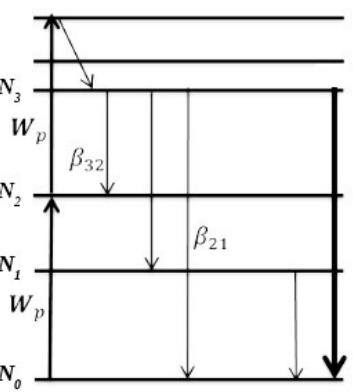
Figure 2. Energy level diagram for Er 3+ with all the important processes for up-conversion, as described in Reference [12].